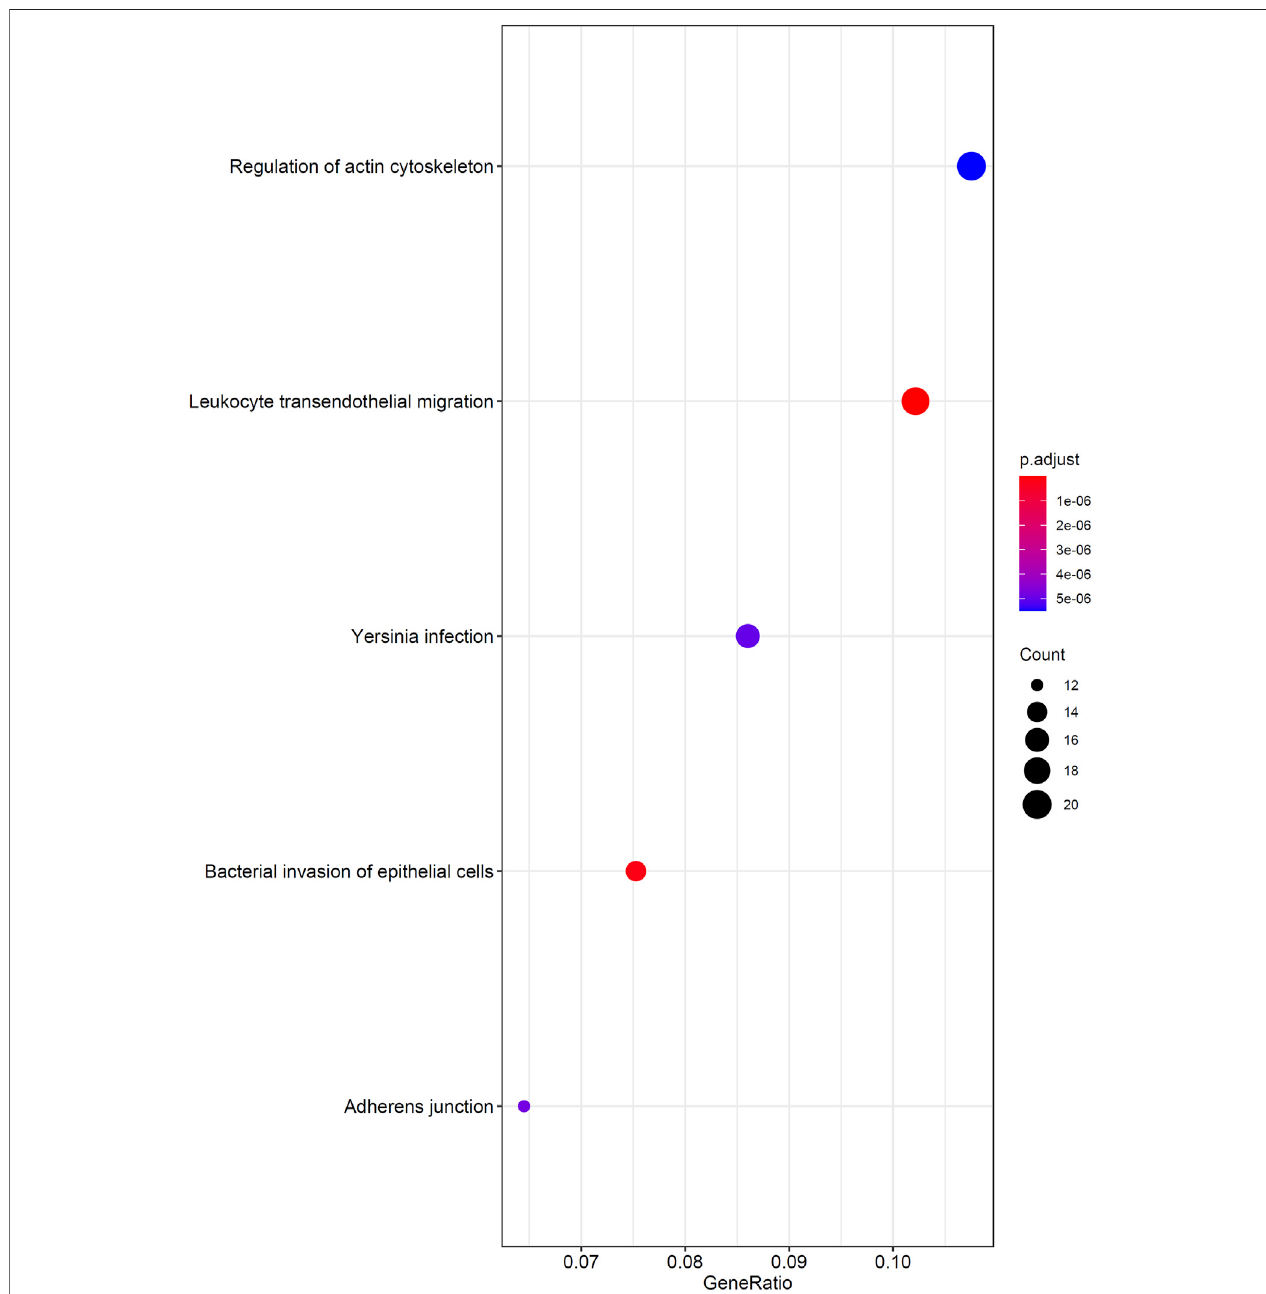
FIGURE 6 | Top enriched KEGG pathways to the top 400 genes in the mRMR feature list.